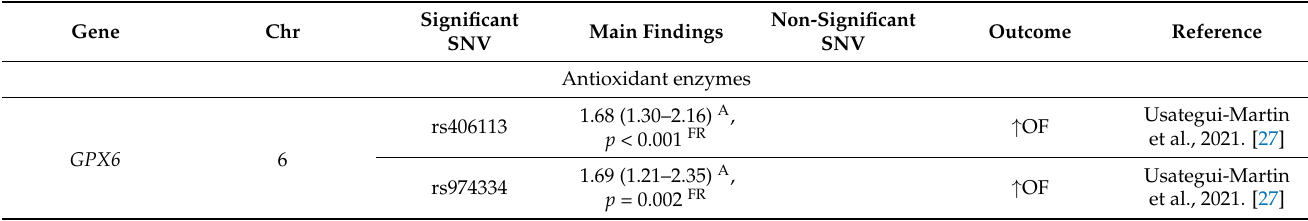
Table 3. Polymorphisms related to oxidative stress and osteoporotic fracture